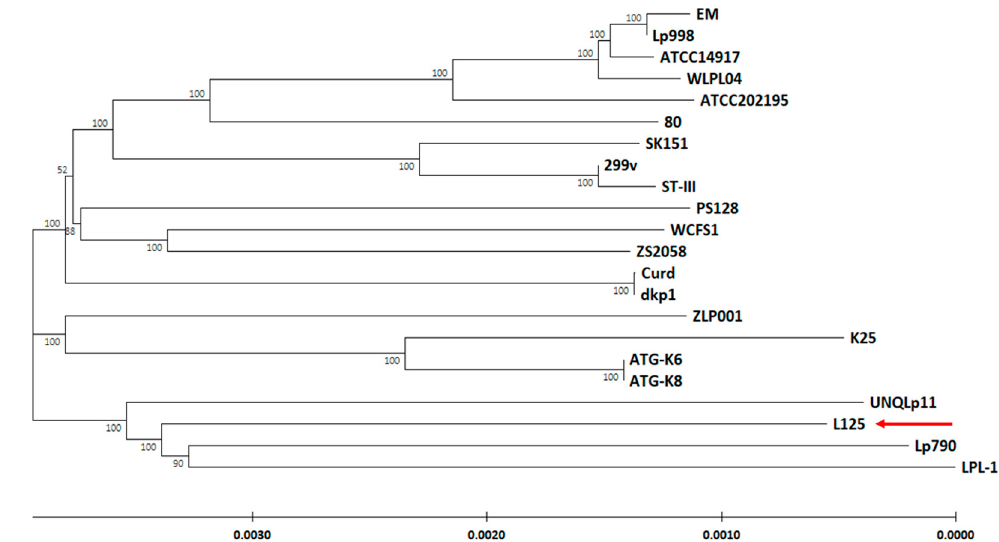
Figure 2. Neighbor-joining phylogenetic tree of L. plantarum L125 and 21 potential probiotic L. plantarum strains based on orthologous genes. The tree was constructed using 1000 bootstrap replicates, calculated by MEGAX (version 10.1.8). The red arrow indicates the position of L. plantarum L125 in the phylogenetic tree.